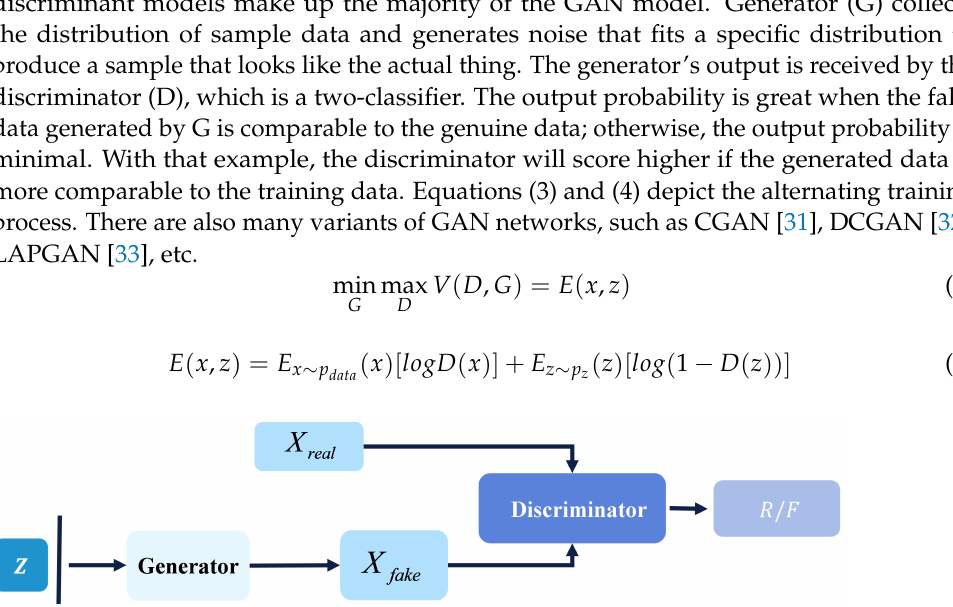
Figure 8. The model architecture of generative adversarial networks, where the generator generates fake data and the discriminator reasonably identifies the original data and the generated fake